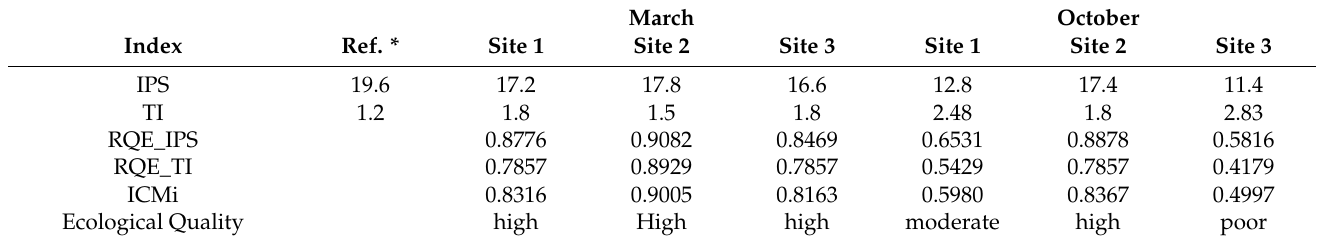
Table 2. Assessment of the ecological status of the Toce River, based on biofilm diatom